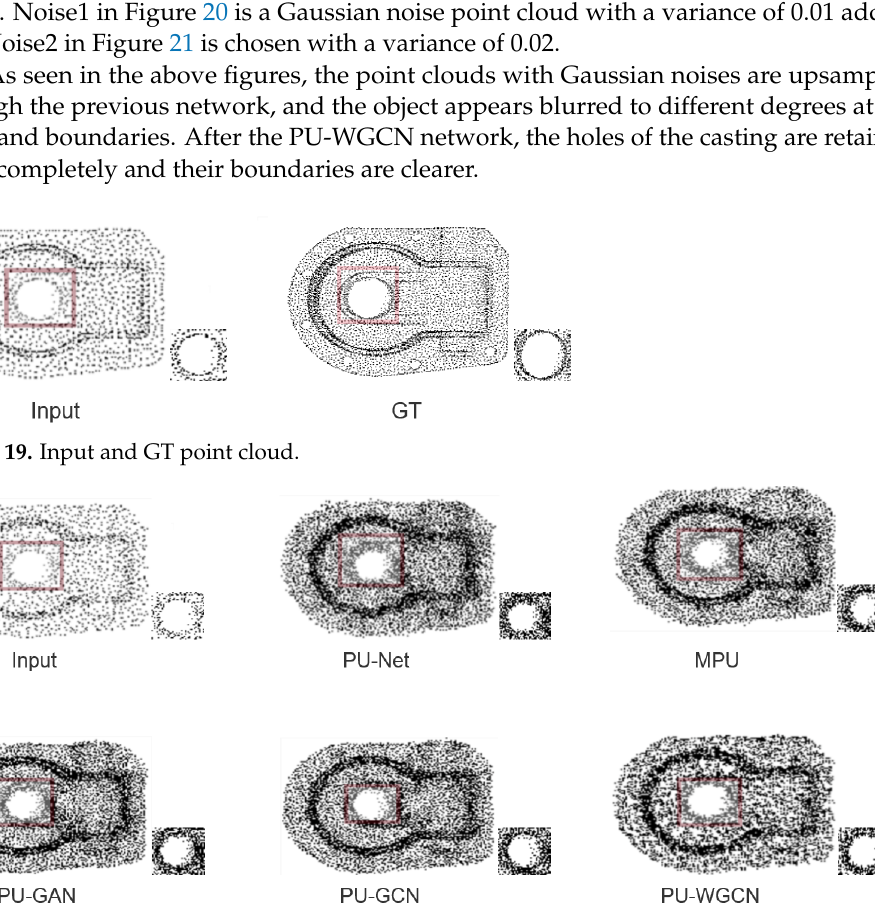
Figure 20. Robustness test by adding Gaussian noise with a variance of